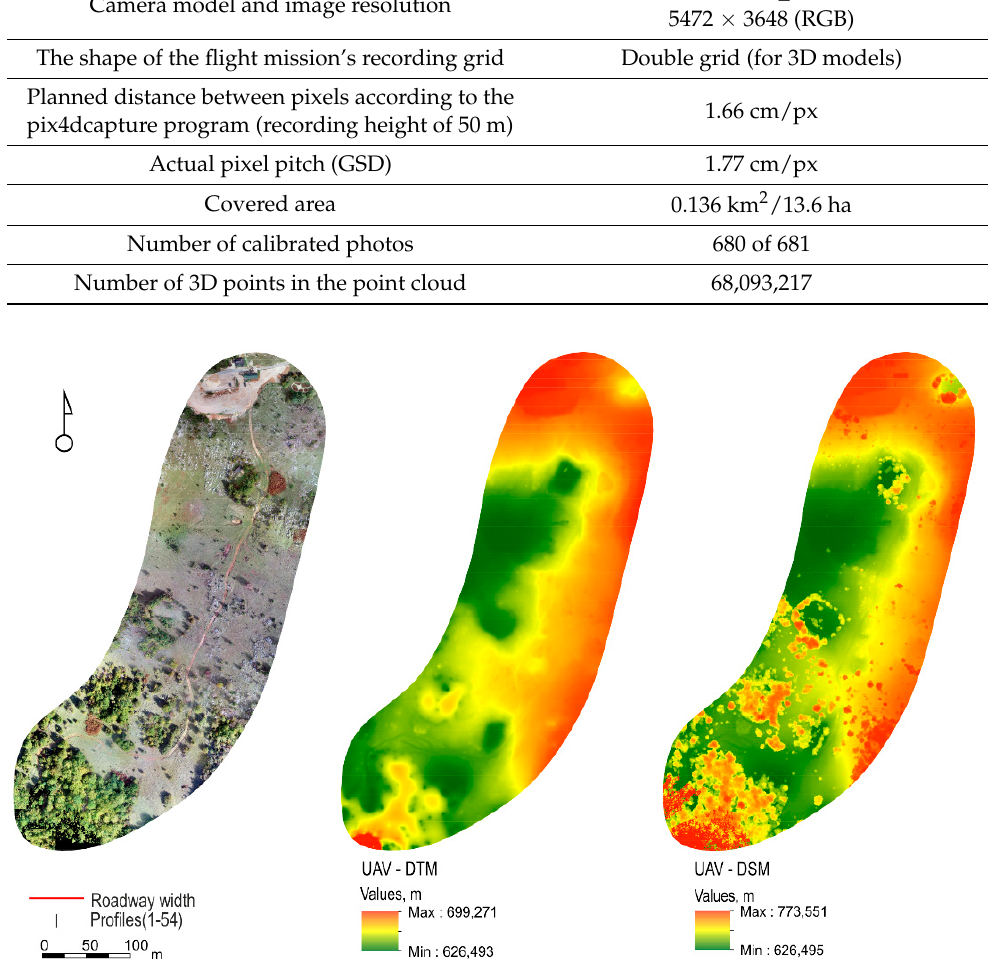
Figure 4. Processing results of UAV recording (from left: orthomosaic, DTM, and DSM). Table 1. Parameters of the processed footage of the UAV device.